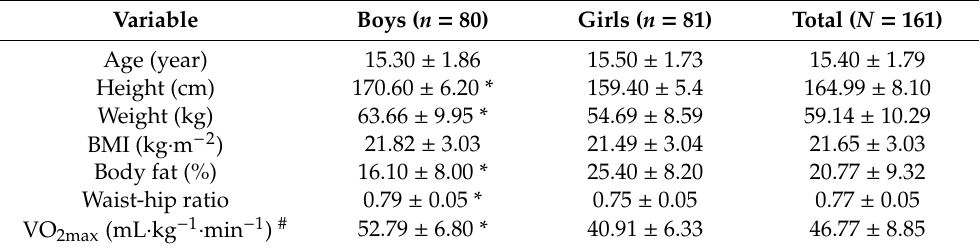
Table 2. Descriptive characteristics (mean ± SD) of the participants in this study.